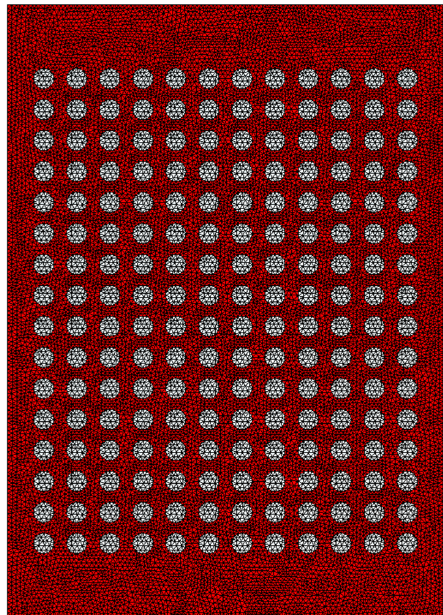
Figure 2. The mesh of the blanket.